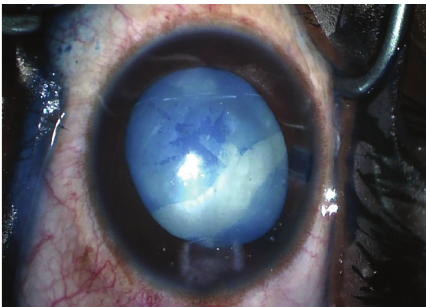
Figure 1: This photo demonstrates the “Argentinian flag” sign with the capsulorhexis extending peripherally.